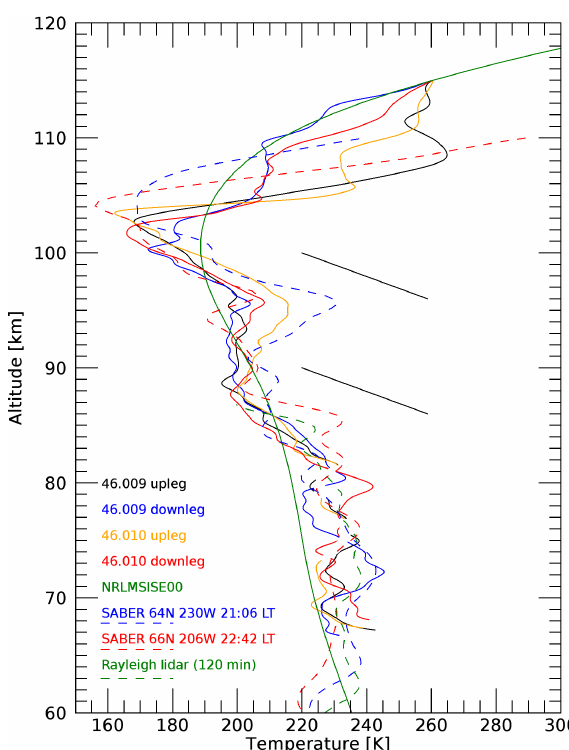
Figure 7. Temperature profiles (solid lines) derived from densities in Fig. 4. Start values at 115km were chosen from MSIS (green line). Individual SABER temperature profiles (blue and red dashed lines) obtained during that night in this area show good agreement with the general temperature structure. The legend lists times and tangent point location for these profiles. The Rayleigh lidar pro- file was obtained by integrating data from 23:30 to 01:30LT (green dashed line). The two straight solid lines indicate the adiabatic gra- dient of − 9 . 7Kkm − 1